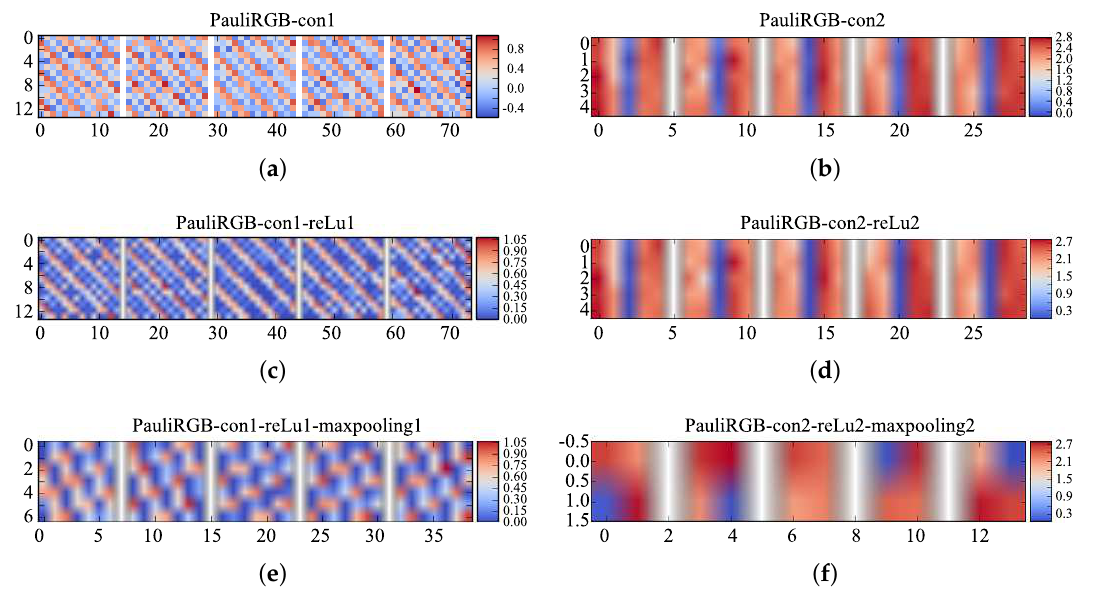
Figure 16. Visualized feature maps of the PauliRGB-input. ( a , c , e ) denote the visualized feature maps of the convolution operation, ReLu operation and max-pooling operation in the first round of feature extraction; ( b , d , f ) denote the visualization in the second round of feature